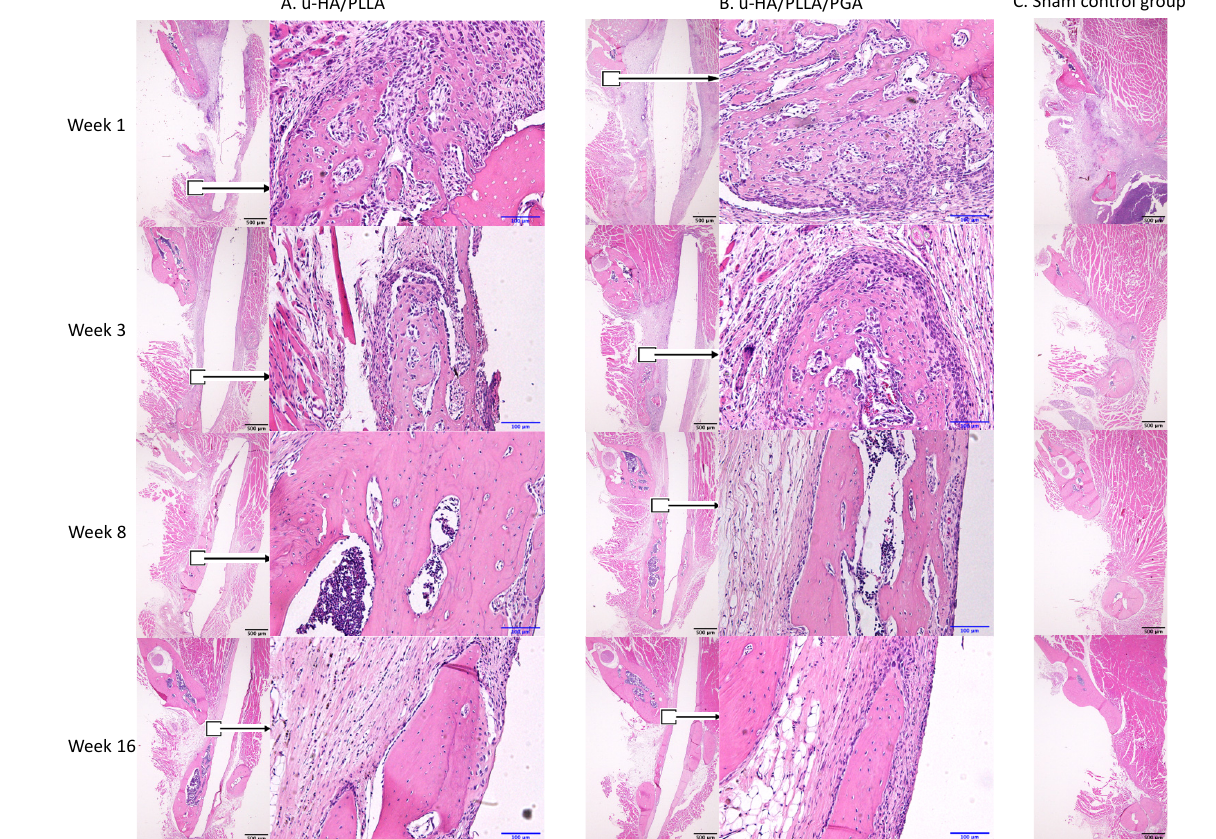
Figure 9. Hematoxylin and eosin-stained sections from the u-HA/PLLA, u-HA/PLLA/PGA, and sham control groups at weeks 1, 3, 8, and 16. Images in each subgroup were taken at 1.25 × and 20 × magnification (from left to right). Images of the sham control group were taken at 1.25 × magnification. ( A ) u-HA/PLLA group. ( B ) u-HA/PLLA/PGA. ( C ) Sham control group. Scale bars: 100 μ m (blue), 500 μ m (black).